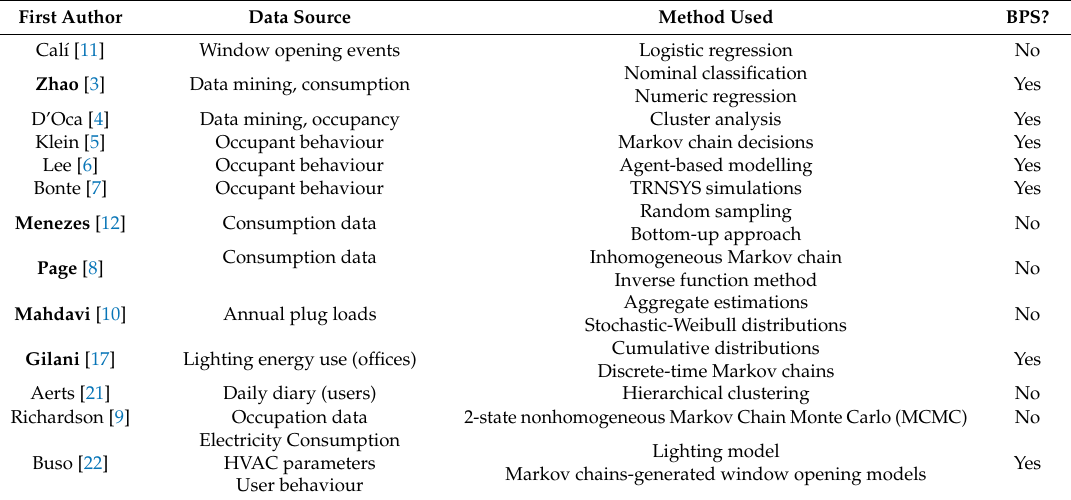
Table 1. Literature data source and